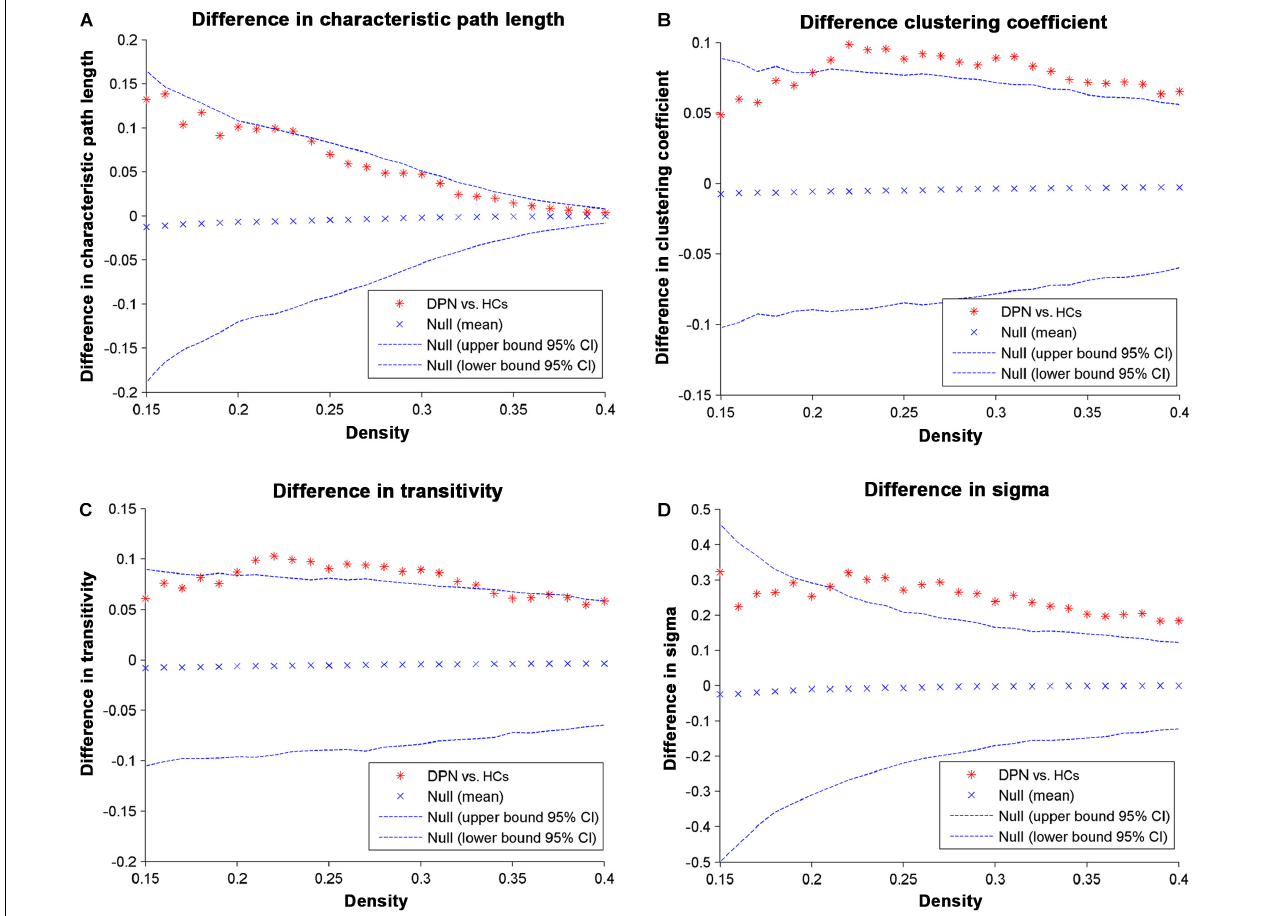
FIGURE 3 | Differences between HCs and DPN patients in global network parameters as a function of network density. The 95% confidence intervals and group differences in the (A) characteristic path length, (B) clustering coefficient, (C) transitivity, and (D) sigma. The ∗ marker denotes the difference between HCs and DPN patients; the ∗ signs lying outside of the confidence intervals indicate the density where the difference is significant at P < 0.05. The positive values indicate DPN patients > HCs, and negative values indicate DPN patients < HCs.